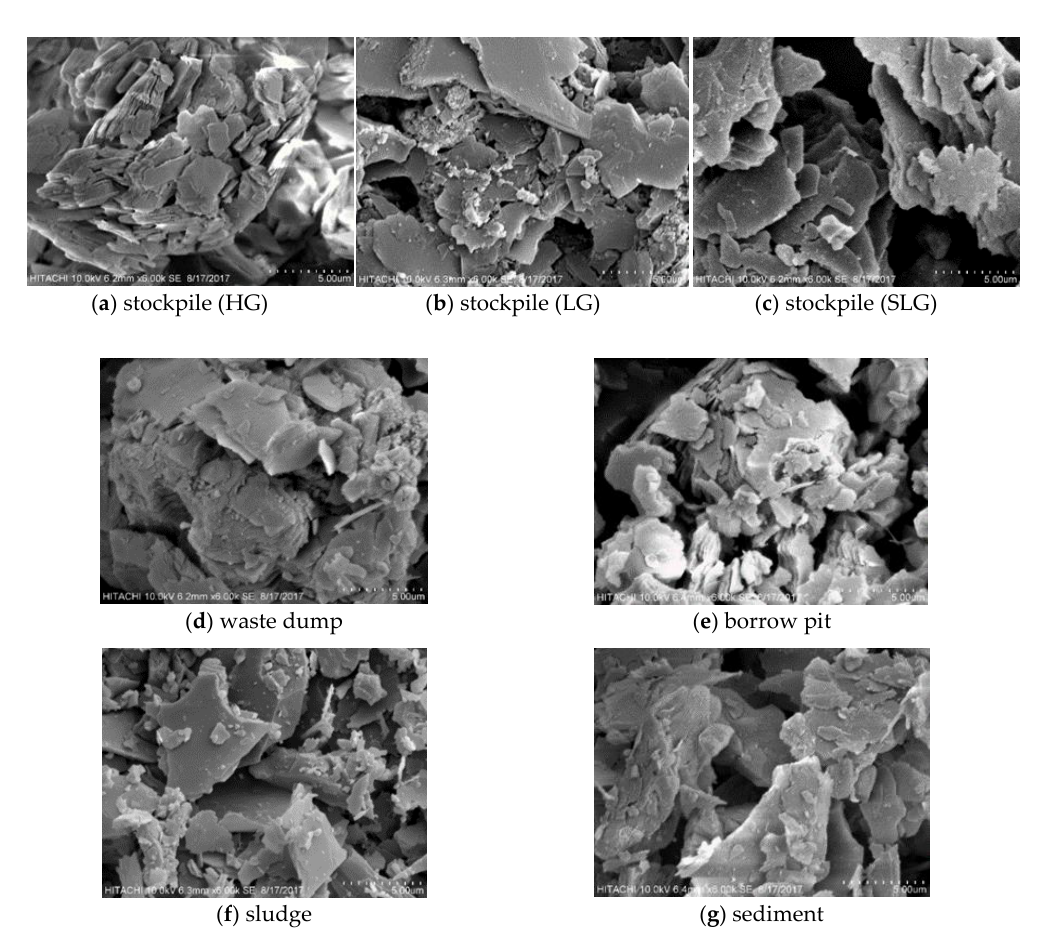
Figure 4. Scanning electron micrographs of soil samples at stockpile ( a ) HG, ( b ) LG, ( c ) SLG, ( d ) waste dump, ( e ) borrow pit; and ( f ) sludge and ( g ) sediment from mine tailings at magnification of 5 µm.